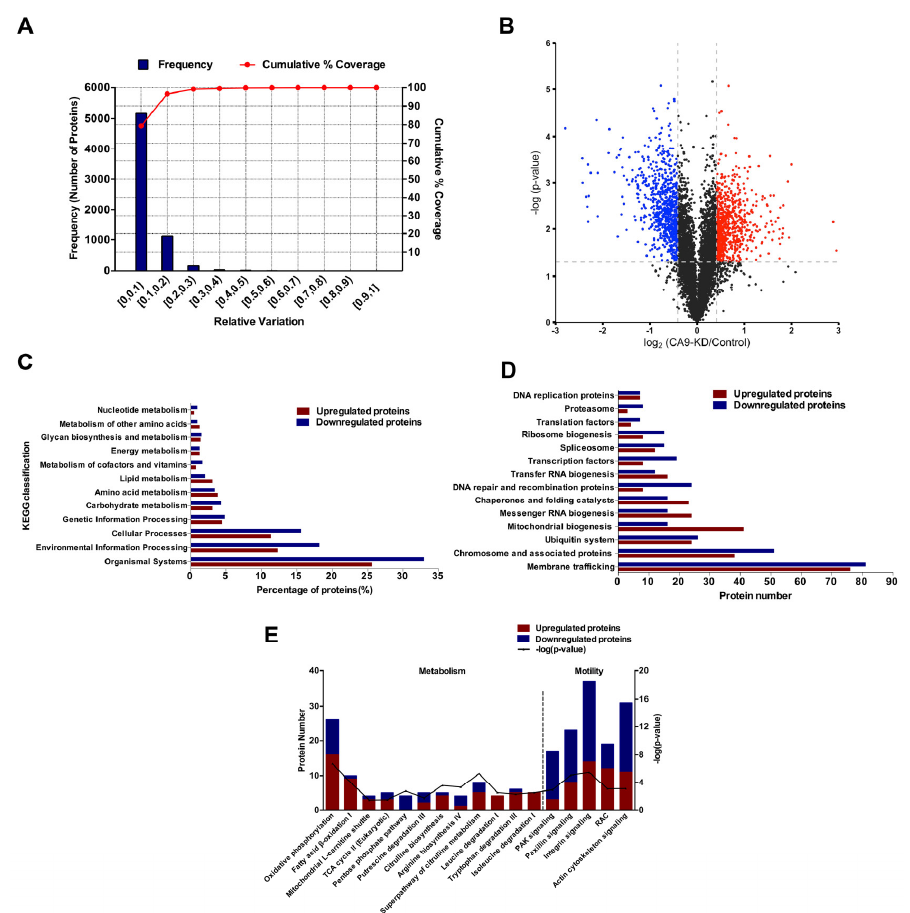
Figure 2. Functional classification of di ff erentially expressed proteins (DEPs) in proteomics analysis of 786-O CA9 knockdown cells compared with control cells. ( A ) Experimental variations of proteomics analysis between 786-O-CA9-KD cells and control cells. ( B ) A volcano plot of proteins based on p -values and ratios of protein expressions in 786-O-CA9-KD cells compared with control cells. Blue and red dots indicate the downregulated and upregulated proteins with significant di ff erence ( p -values < 0.05, ratios ≤ 0.75 or ≥ 1.33), respectively. ( C ) The upregulated and downregulated proteins after CA9 knockdown in 786-O cells were classified by Kyoto Encyclopedia of Genes and Genomes (KEGG) BlastKOALA. ( D ) Numbers of upregulated and downregulated proteins participating in genetic information processing. Most mitochondrial biogenesis proteins were upregulated in CA9 knockdown cells. ( E ) Representative canonical pathways enriched in DEPs after CA9 knockdown in 786-O cells, analyzed by IPA (Ingenuity Pathway Analysis).